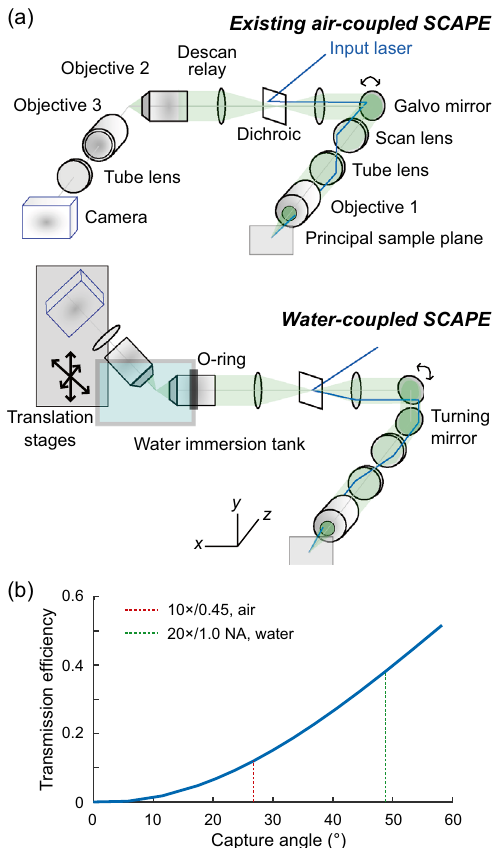
Figure 1. A water immersion system coupled two water immersion objectives and increased the SCAPE transmission efficiency. ( a ) Top : Conventional SCAPE scans an excitation oblique light sheet through the sample with a galvo mirror. It then descanned emission from the light-sheet through the same galvo mirror. It finally used a pair of air objectives, objective 2 and 3, to rotate the oblique light sheet to a fixed plane on the camera. Bottom : Water-coupled SCAPE employs the same principles as conventional SCAPE, but employs two high NA water immersion objectives as objectives 2 and 3. The panel labels highlight critical design differences between conventional SCAPE and water-coupled SCAPE: a water immersion tank coupled the two objectives, with objective 2 sealed in place with an O-ring; the imaging pathway starting with objective 3 was freely able to move via multiple translation stages and align to the intermediate image after objective 2; a turning mirror after the galvo mirror in the excitation pathway matched the excitation plane to the imaging plane defined by the objective 2-to-objective 3 coupling direction. ( b ) We calculated the transmission efficiency in the emission path from the objective 2 back aperture to the objective 3 back aperture as a function of the capture angle of objective 3. We fixed the oblique angle between the two objectives to 38°, and the objective 2 capture angle to 48°, representative of both a 0.75 NA air objective and a 1.0 NA water objective. We highlight the two objectives used for objective 3 in this work, the 0.45 NA air objective ( red ) and 1.0 NA water objective ( green ), with vertical